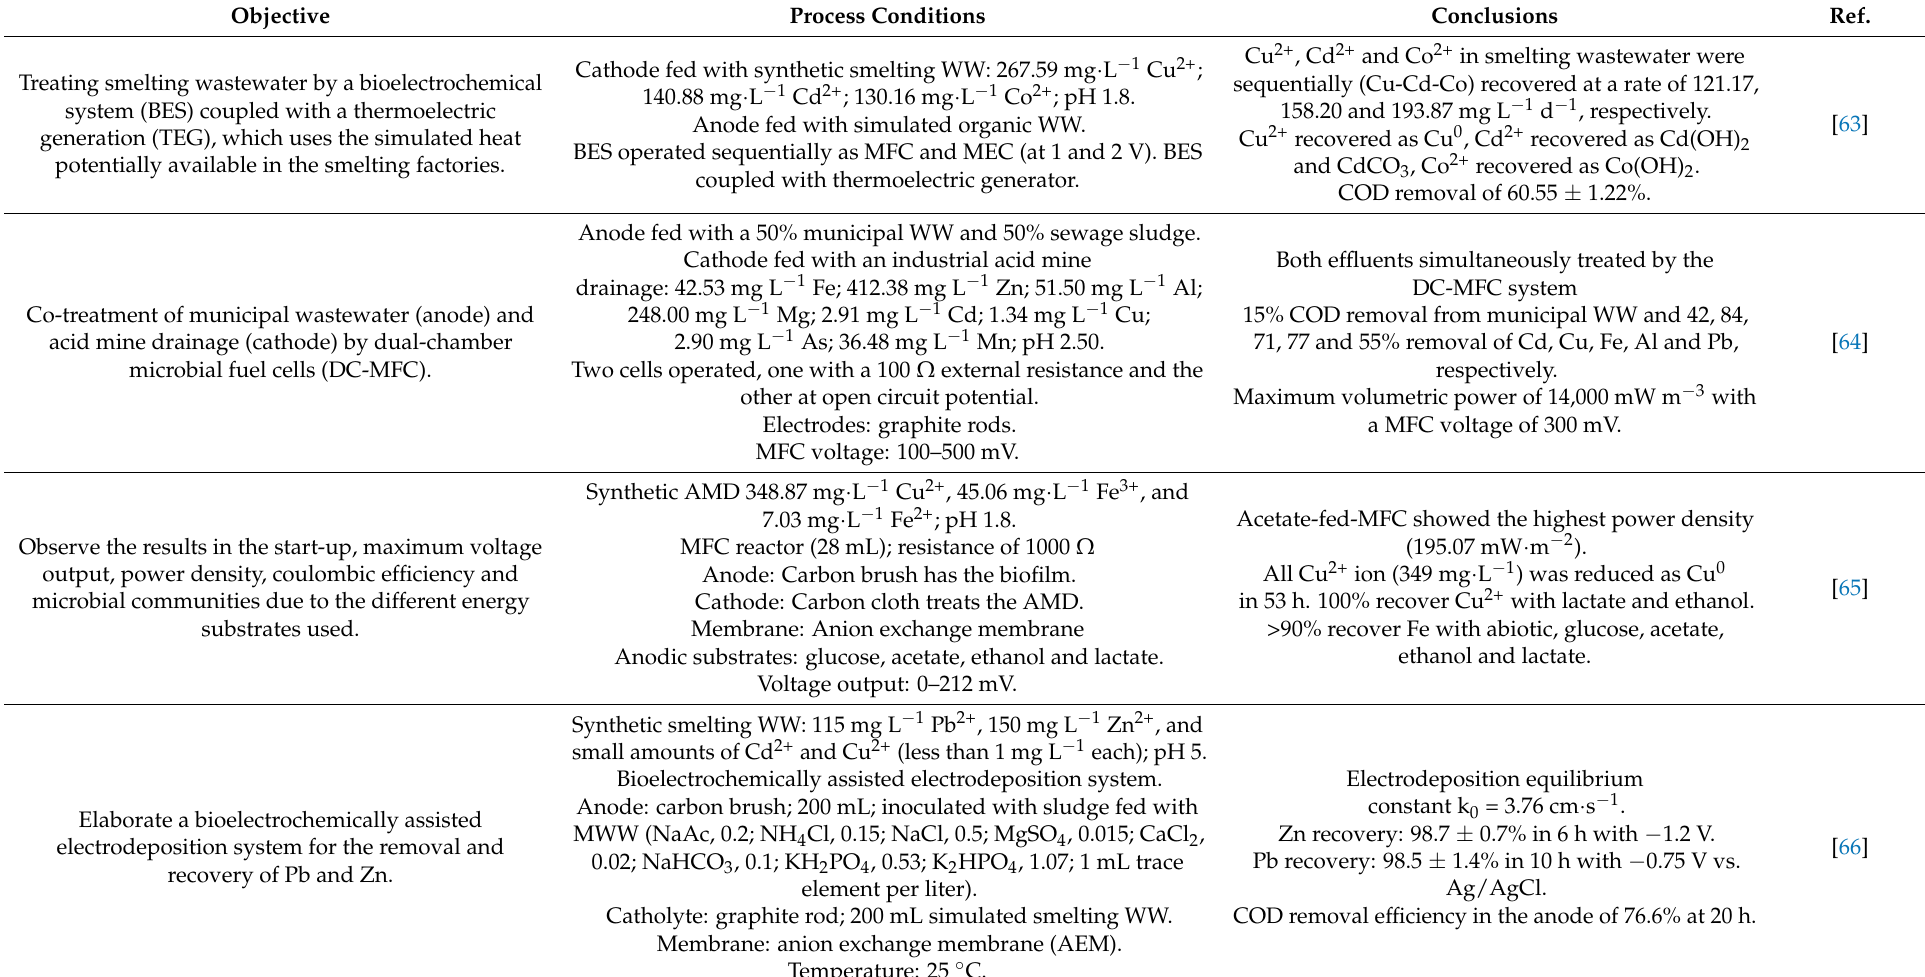
Table 3. Bio-electrochemical processes for metal recovery. Objective Process Conditions Conclusions